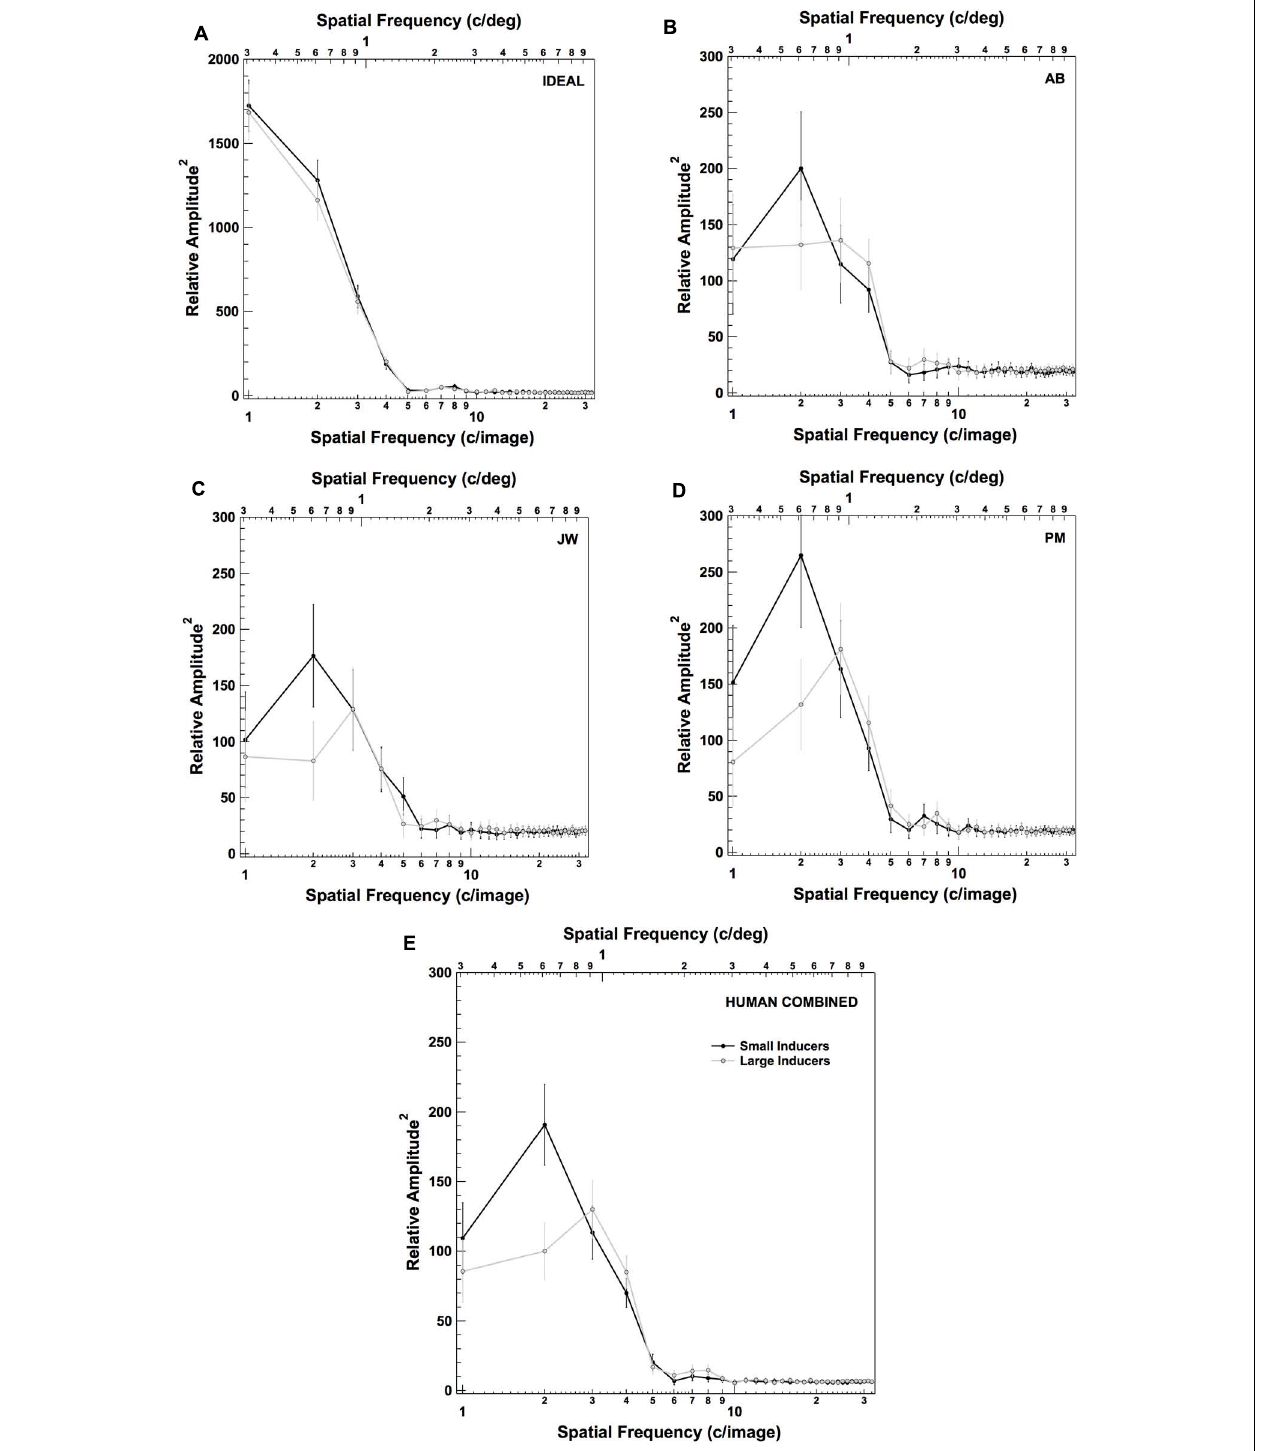
FIGURE 6 | Frequency domain representation of the raw classification images for the ideal observer (A), three human observers (B–D) and the combined data across all three human observers (E) in each condition of Experiment 2. Error bars correspond to ± 2 standard deviations (estimated by bootstrap simulations; see text for